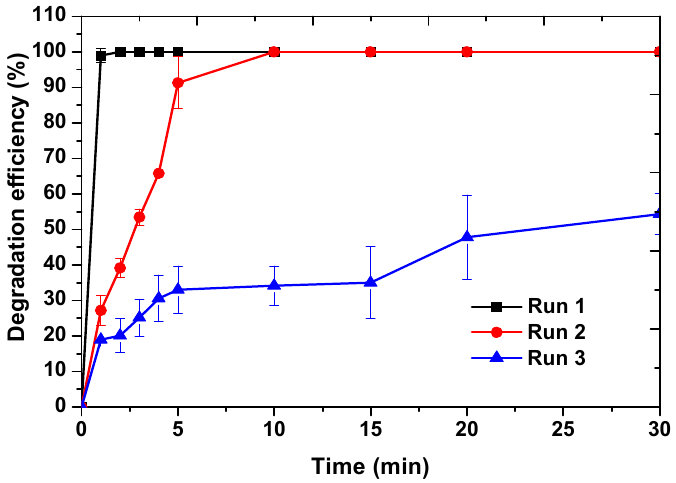
Figure 9. Degradation efficiencies of 10 mg/L methyl orange (pH= ~ 4.5) using 10 mg Fe/Cu/Ag 5:1:0.2 nanoparticles for 30 min in different batch runs.